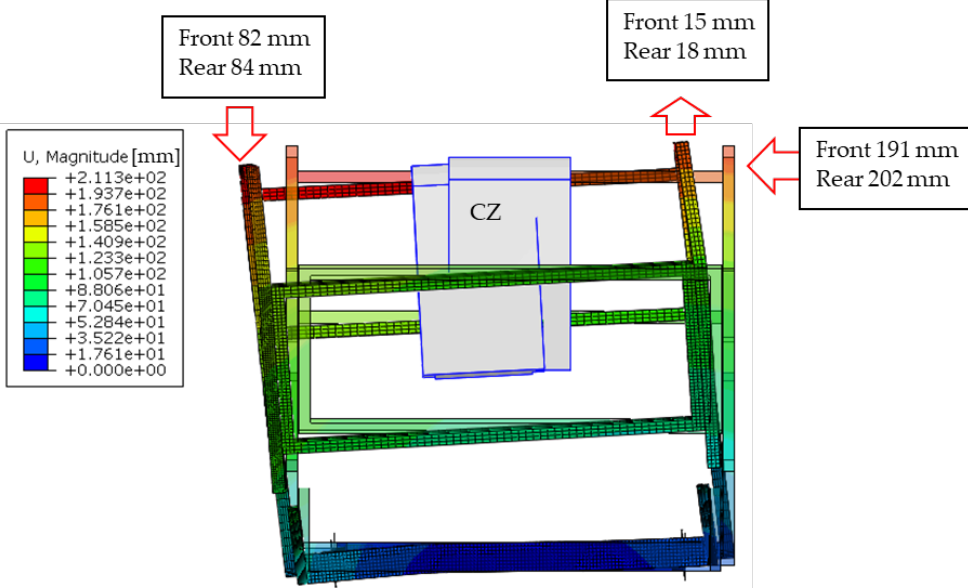
Figure 8. Permanent deflection of the ROPS structure after the entire sequence of OECD Code 4 testing procedure: dis- placement contour plot front view with the clearance zone (expressed in mm).